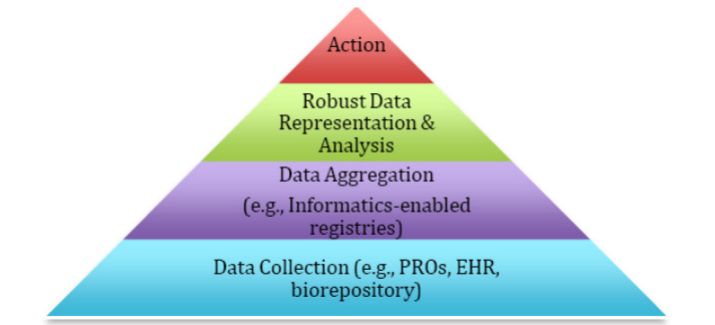
Figure 1. The Requirements for Personalized